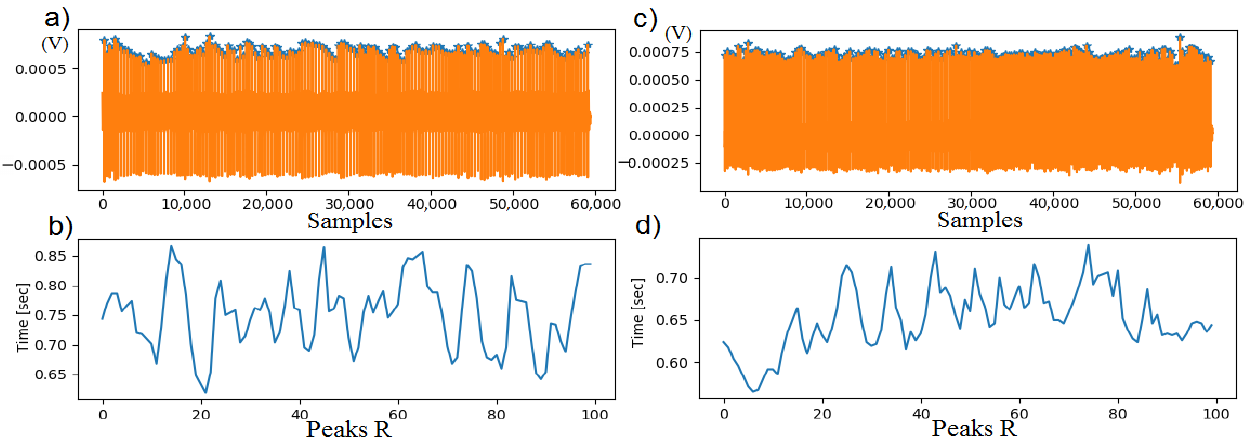
Figure 17. ECG and HRV signals: ( a ) ECG in relaxation state, ( b ) HRV signal from (a), ( c ) ECG in a stress state, ( d ) HRV signal from ( c ).